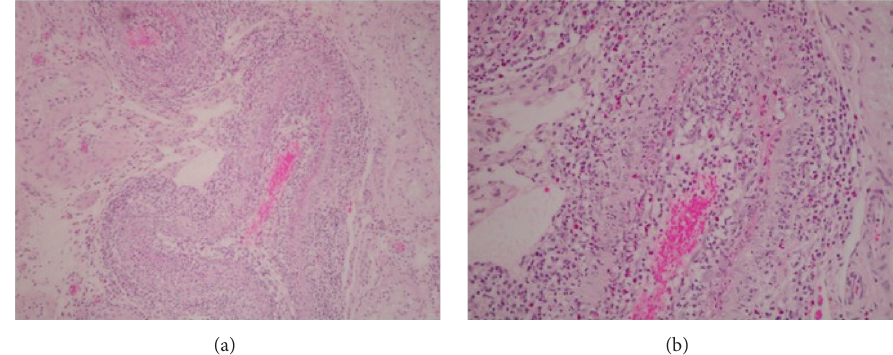
Figure 2: Histological section (H&E stain) of the left testicle viewed at medium (a) and high (b) power demonstrating a proliferation of neutrophils as well as T and B lymphocytes surrounding one of the intratesticular vessels consistent with vasculitis. No granulomas are